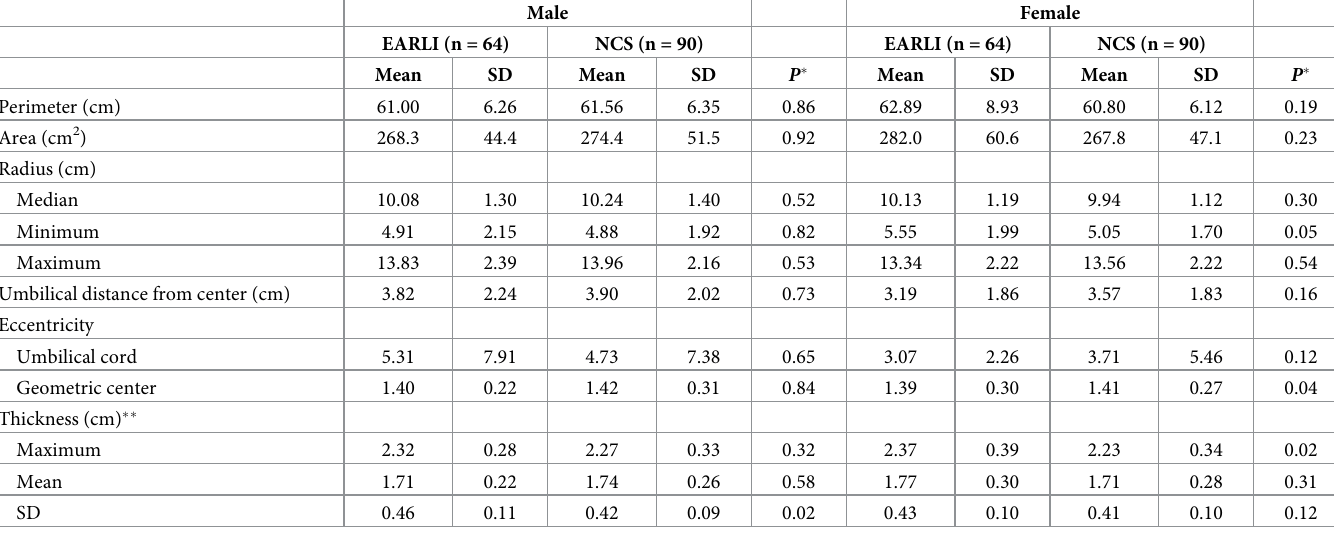
Table 5. Comparison of placental morphology measures between EARLI and NCS by sex using the Wilcoxson rank-sum